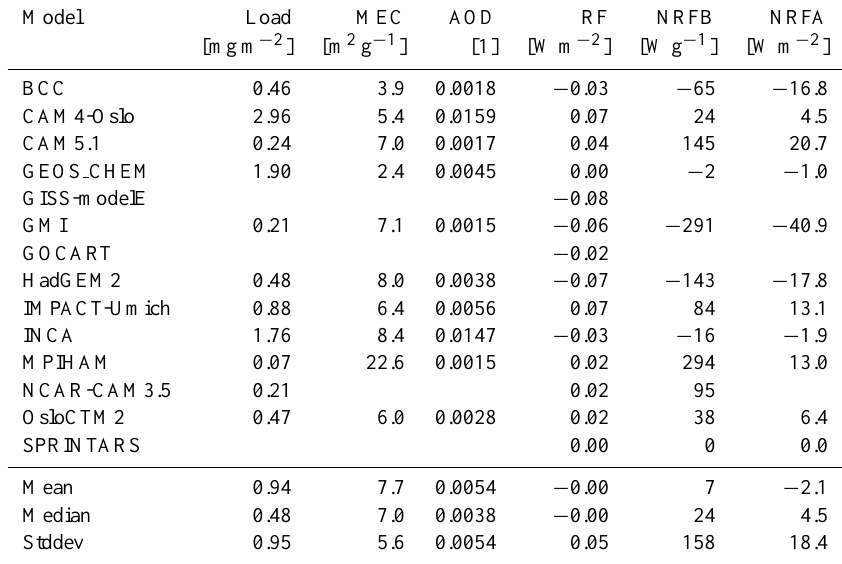
Table 9. Same as Table 4 for combined OA and BC from BB emissions.